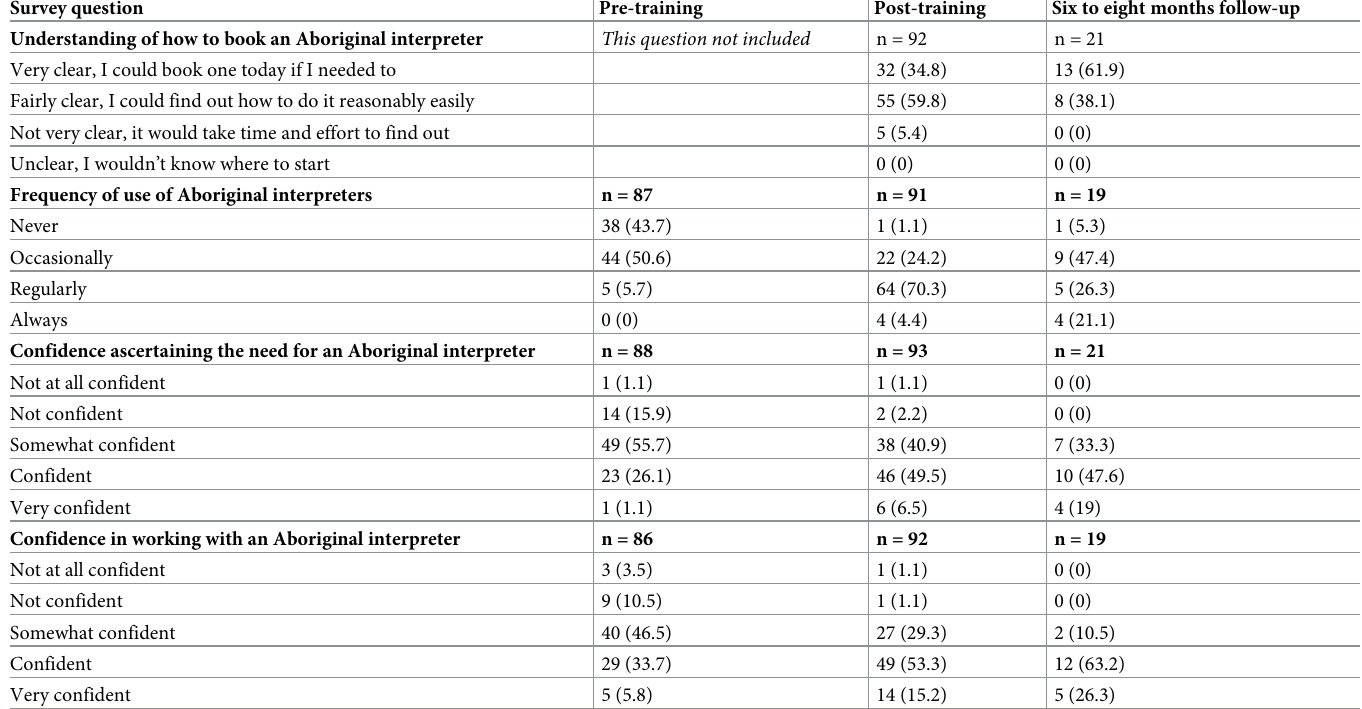
Table 3. Comparison of clinicians clarity on the interpreter booking process immediately after the ‘Working with Interpreters’ training session and at six to eight months follow up. Survey